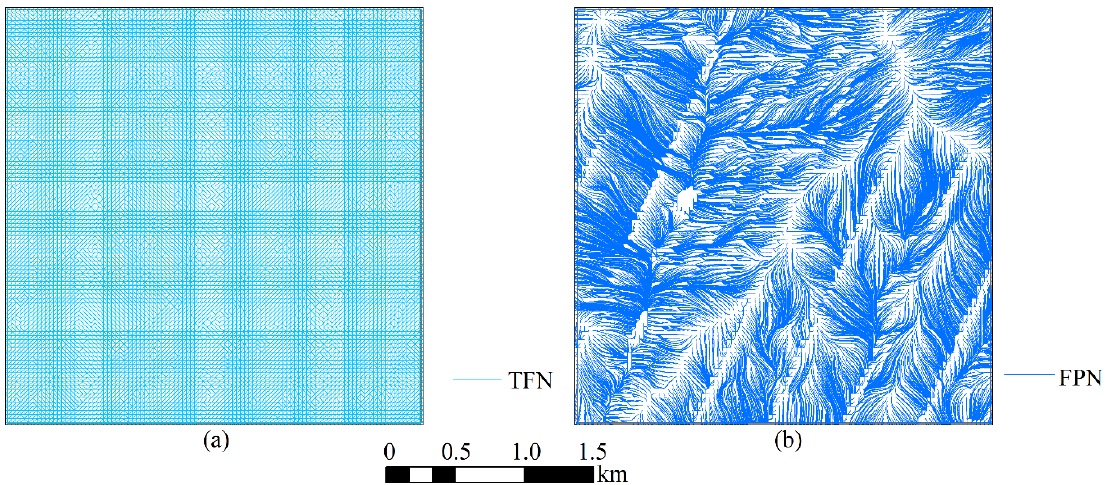
Figure 14. The triangular facet network (TFN) and FPN of the subregion: ( a ) TFN and ( b ) FPN. ISPRS Int. J. Geo-Inf. 2020 , 9 , x FOR PEER REVIEW